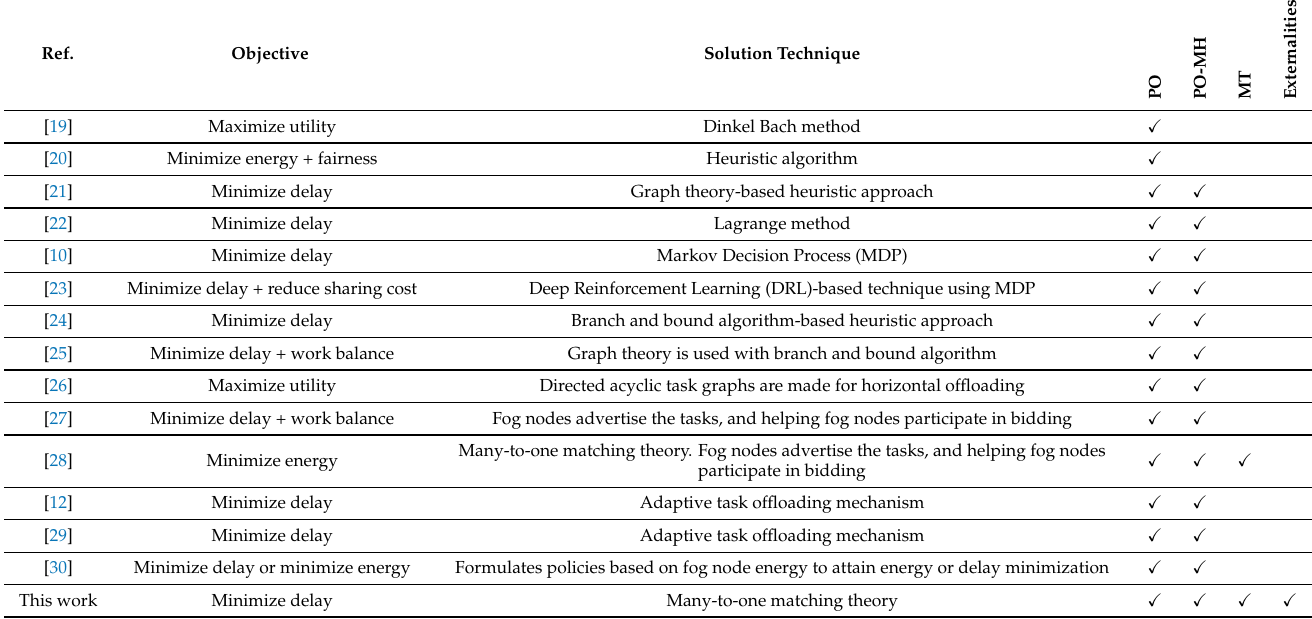
Table 1. Previous work on partial task offloading in fog computing and contributions of this paper.